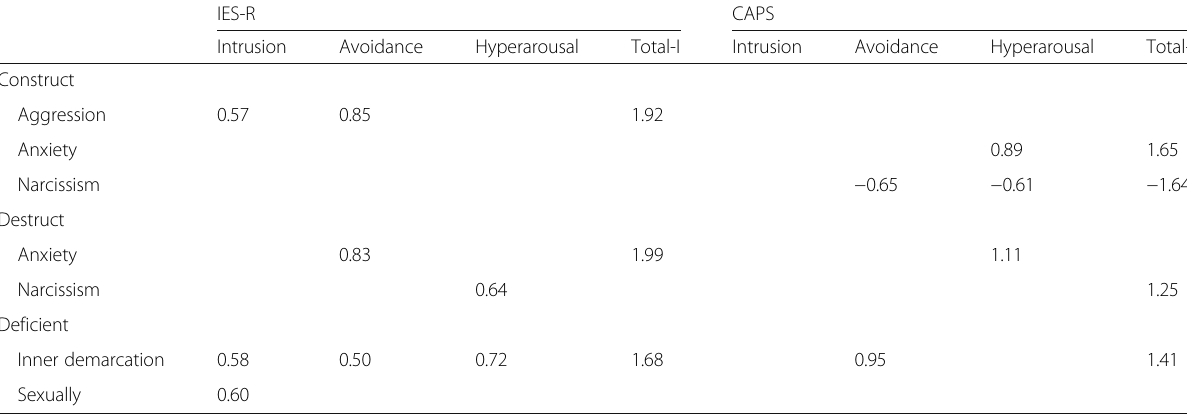
Table 3 Stepwise regression of IES-R and CAPS scores using ISTA scores as determinants